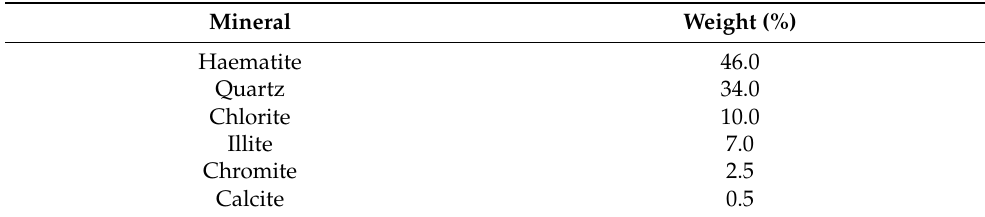
Table 3. Mineralogical composition of the “Triada”